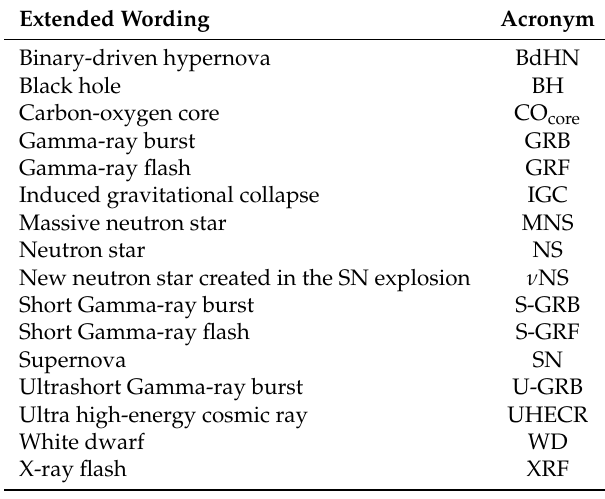
Table 2. Acronyms used in this work in alphabetical